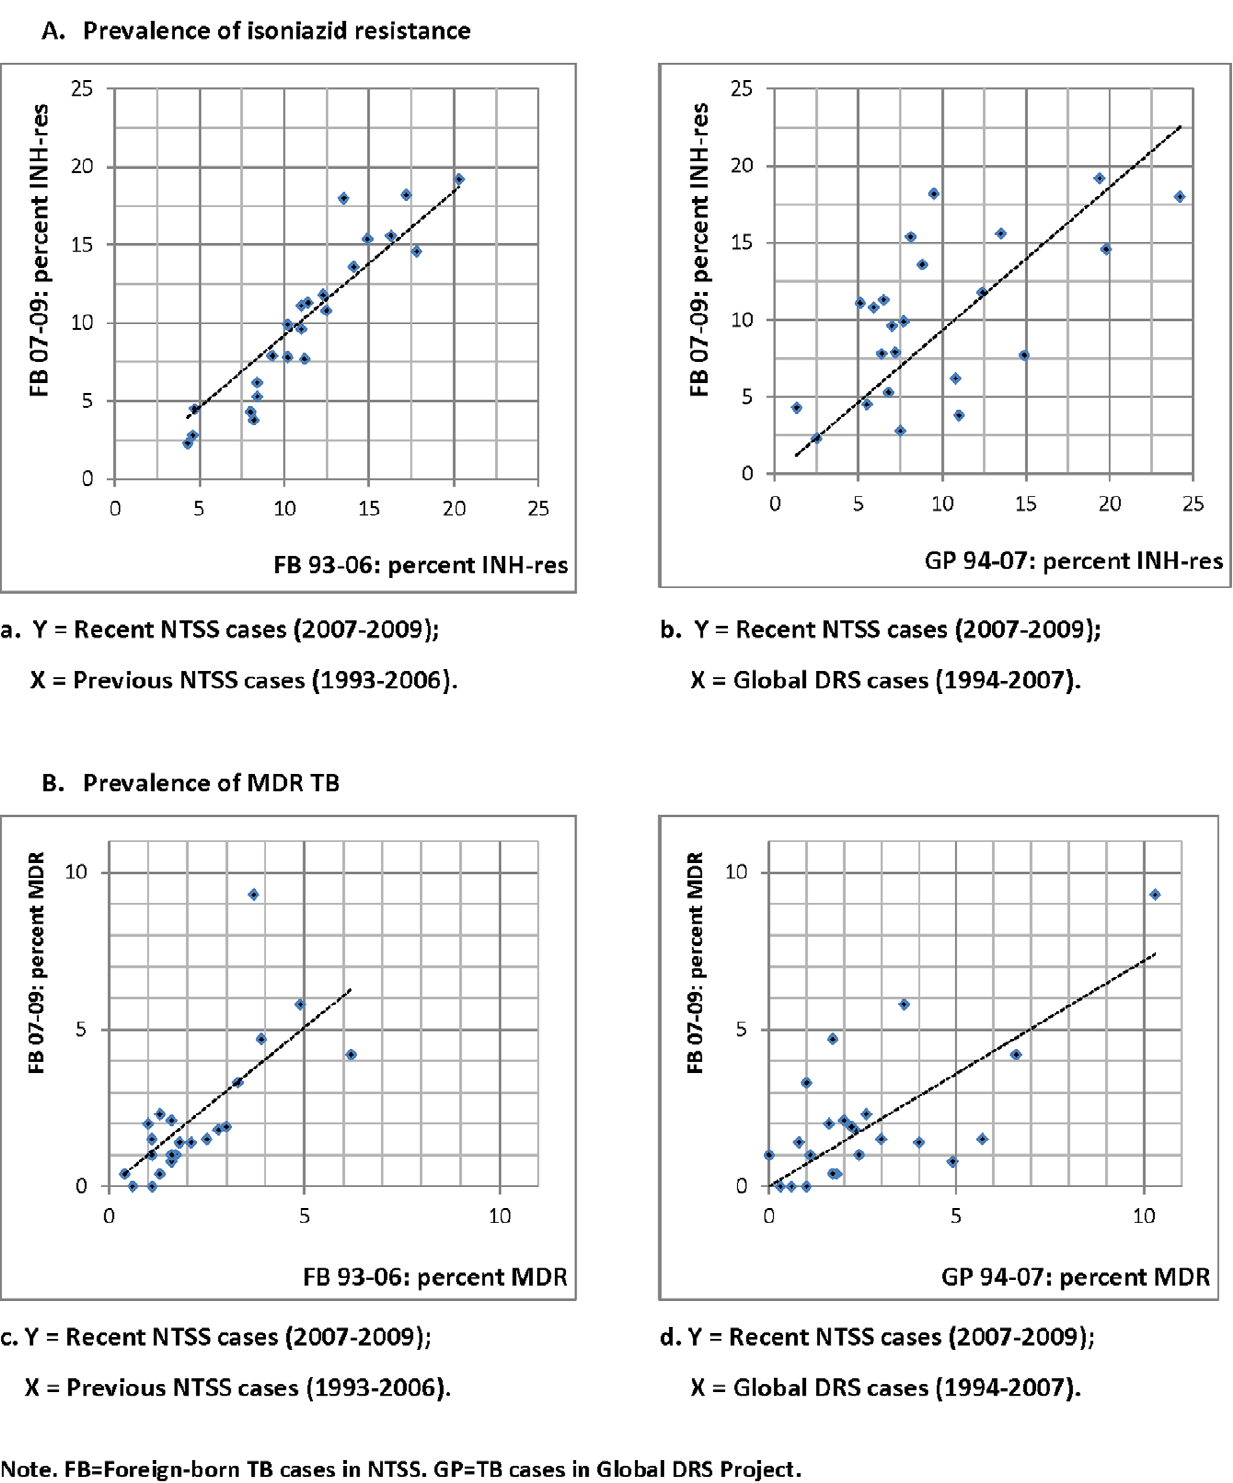
Figure 1. Scatterplots of (A) prevalence of isoniazid resistance among recent foreign-born NTSS cases (2007–2009) versus prevalence of isoniazid resistance among (a) previous foreign-born NTSS cases (1993–2006), and (b) Global DRS TB cases (1994– 2007), and (B) prevalence of MDR TB among foreign-born NTSS cases (2007–2009) versus prevalence of MDR TB among (c) previous foreign-born NTSS cases (1993–2006), and (d) Global DRS TB cases (1994–2007). Each dot represents a country or a region as specified in Table 1.